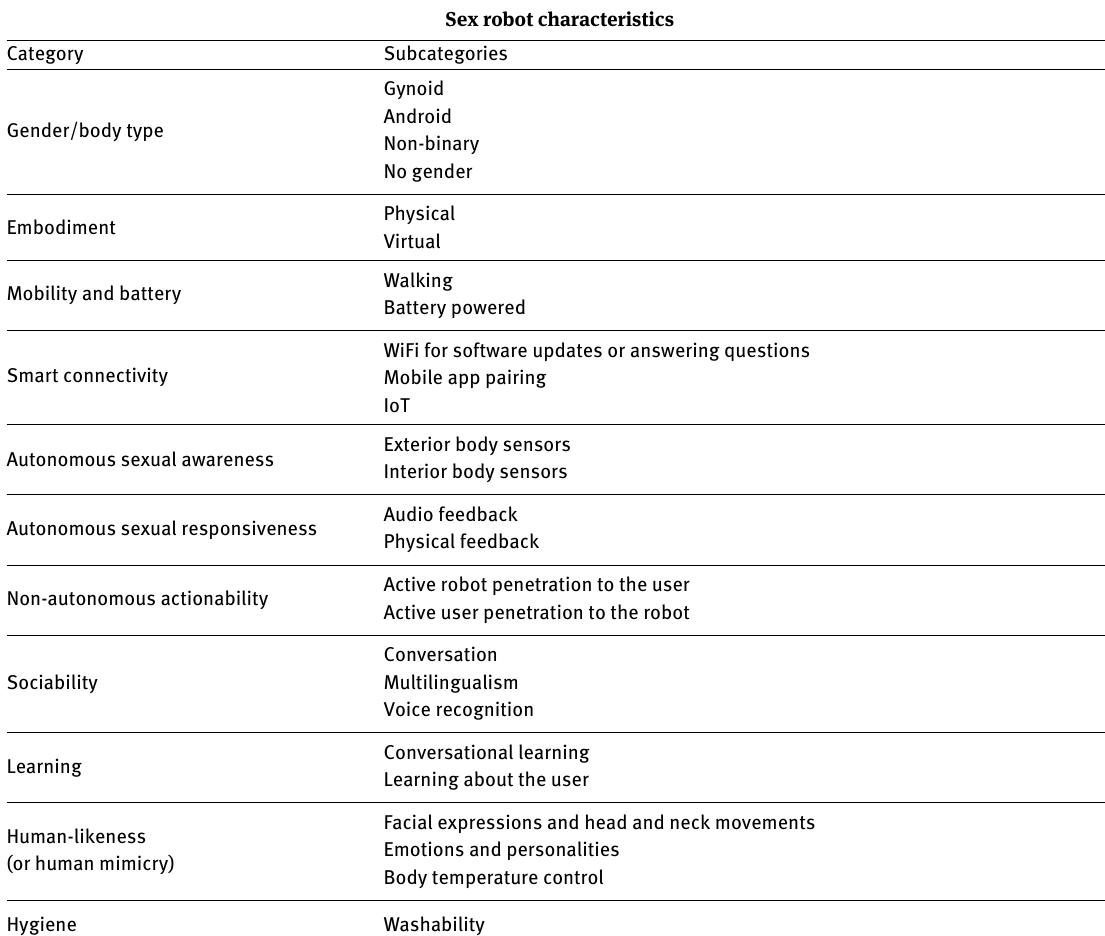
Table 2: Categories (and subcategories within) of sex robot charactertistics identifed through content analysis performed on 12 different sex